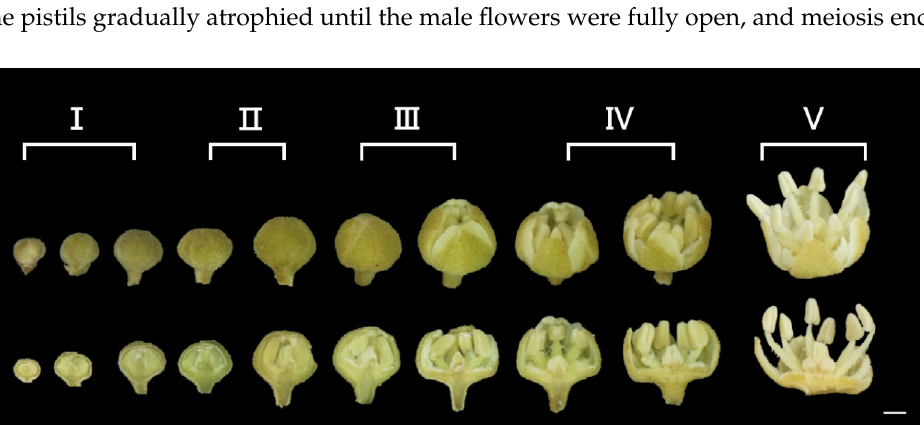
Figure 4. The process of meiosis in ‘Shixia’ microspore mother cells: ( a ) Early-leptotene, ( b ) Late- leptotene, ( c ) Zygotene, ( d ) Pachytene, ( e ) Diplotene, ( f ) Diakinesis, ( g ) Metaphase I, ( h ) Anaphase